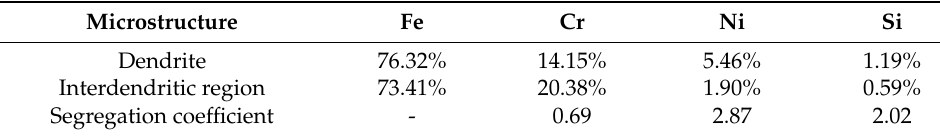
Table 3. Elemental contents of the ingot and their segregation